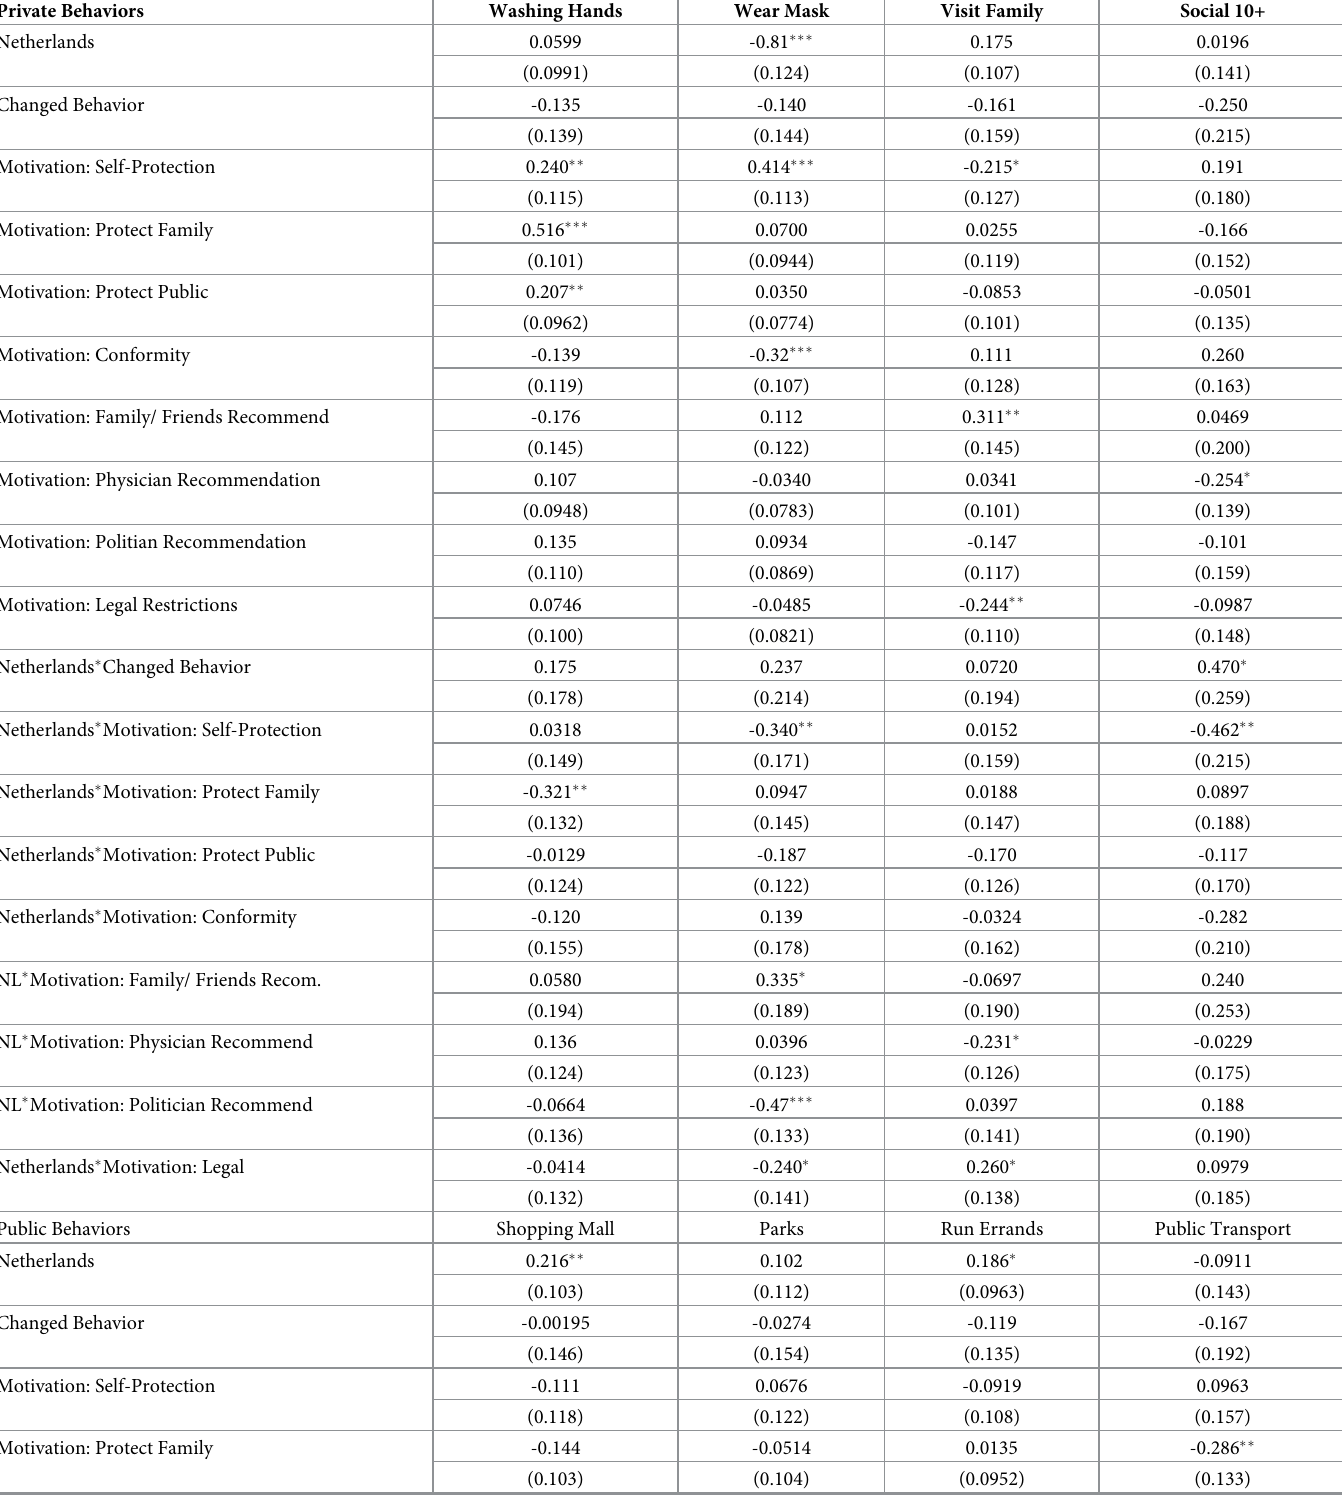
Table 3. The effect of motivations on